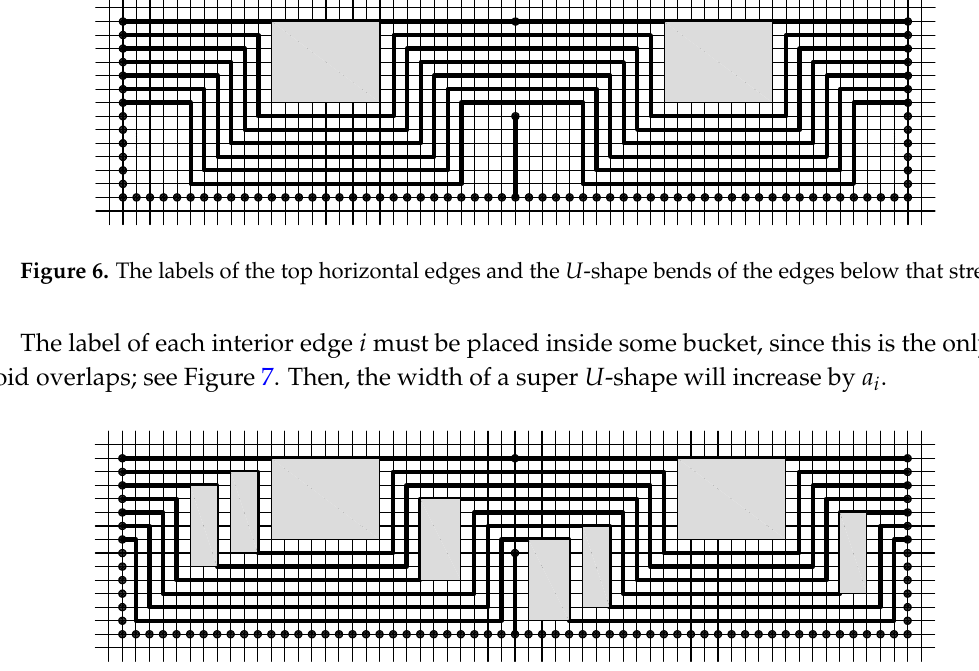
Figure 7. A simple example of an orthogonal drawing corresponding to an instance of the three-partition problem with m = 2, K = 8, B = 7 and weights